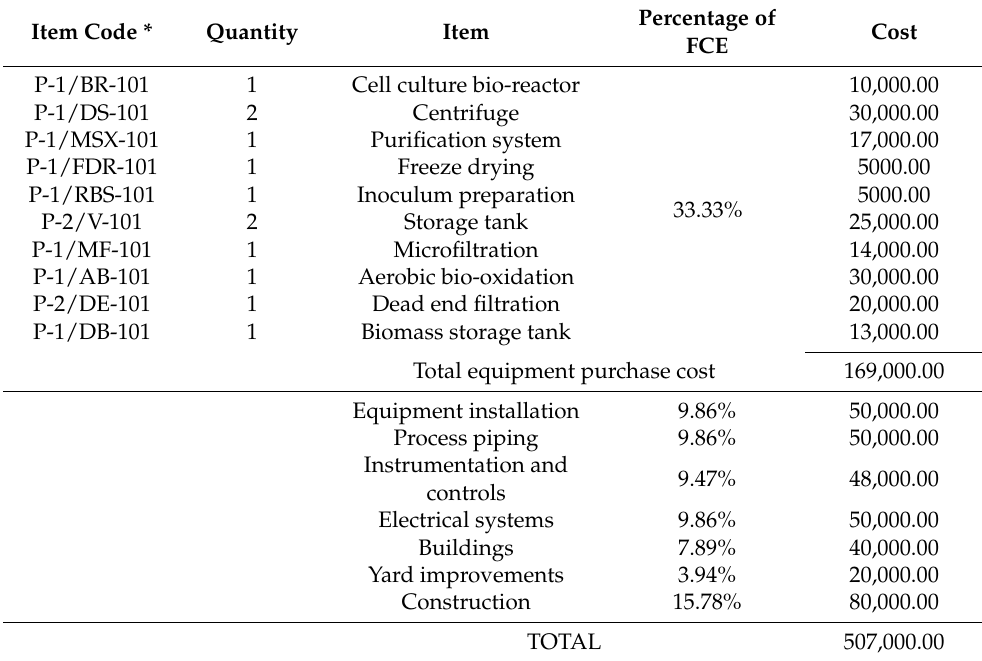
Table 4. The fixed capital estimate (FCE) for production of PhACs by the SUK 25 using the submerged fermentation